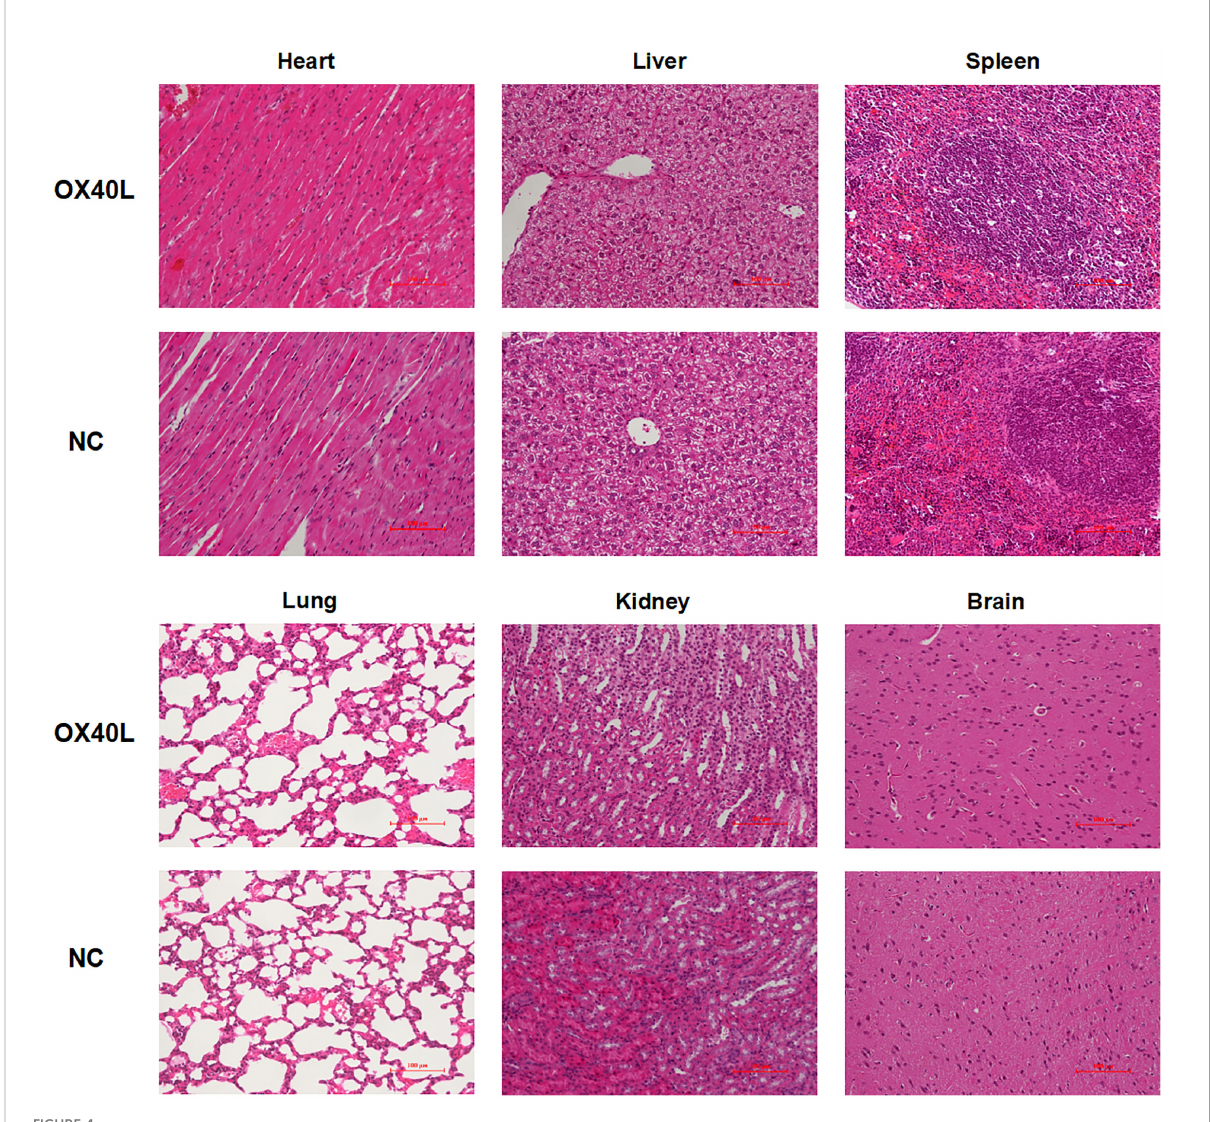
FIGURE 4 Organ toxicity of OX40L mRNA-LNP. Mice were euthanized at the end of treatment and their organs were removed. Heart, liver, spleen, lung, kidney and brain sections were stained with H&E to evaluate organ toxicity (scale bars: 100 m